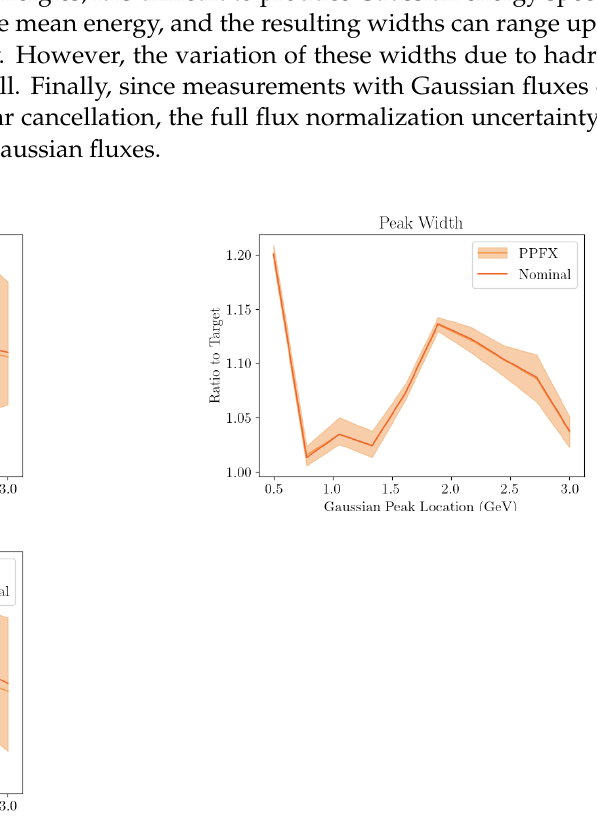
Figure 112. The variation in the mean, width, and normalization for the linearly combined Gaussian neutrino energy spectra from 100 throws of the hadron production uncertainties is shown as a function of the chosen Gaussian mean neutrino energy. “PPFX” is the name of the beam modeling framework that allows for the variation of